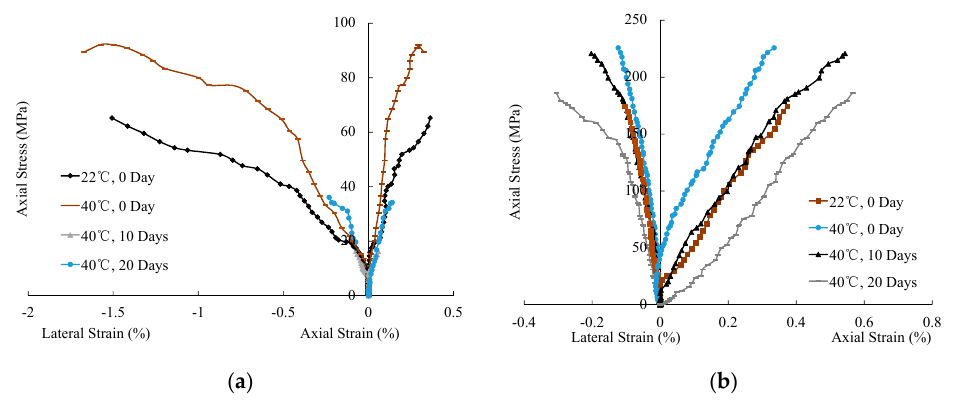
Figure 3. Average Stress–strain curves: ( a ) parallel; ( b ) normal.